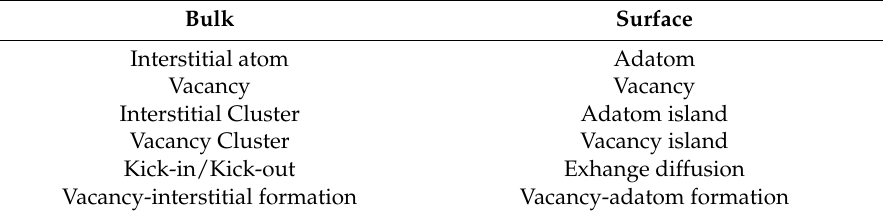
Table 1. Behavioral difference of defects in the bulk and the surface [46].